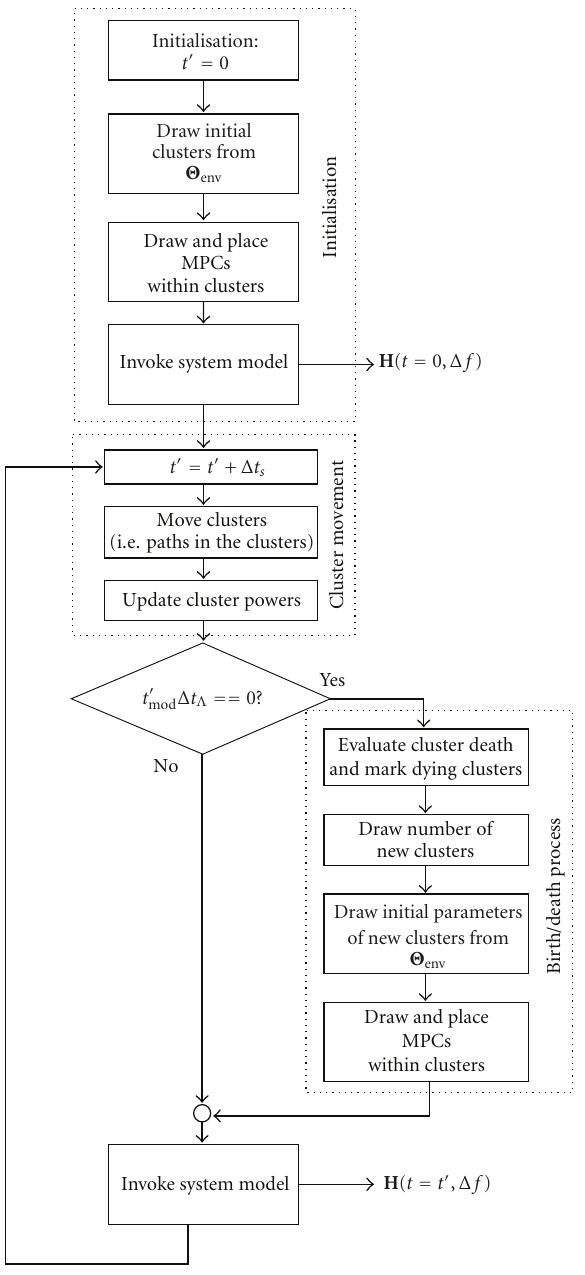
Figure 1: Flow diagram of the Random-cluster model.